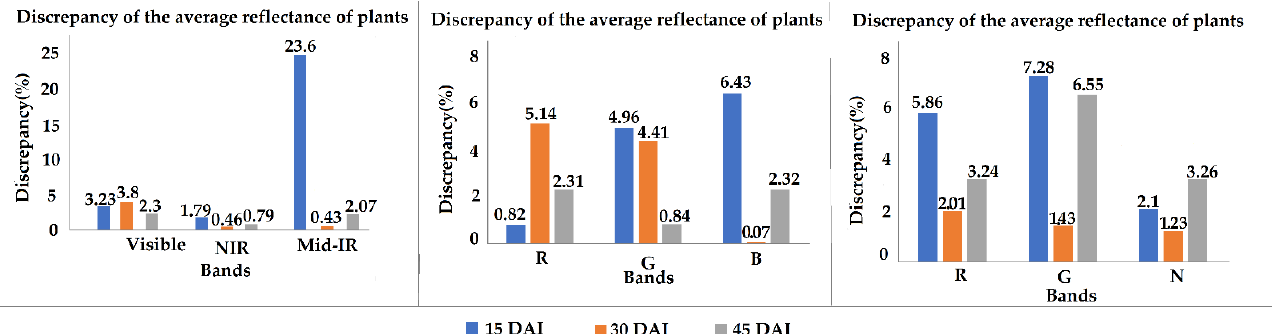
Figure 5. Average reflectance values between inoculated and non-inoculated seedlings at 15, 30, and 45 days after inoculation of the bands: visible, near infrared, and average of the simulated reflectance curves ( a ); bands of red (R), green (G), and blue (B) ( b ), and the bands of red (R), green (G) and near infrared (N) ( c ).